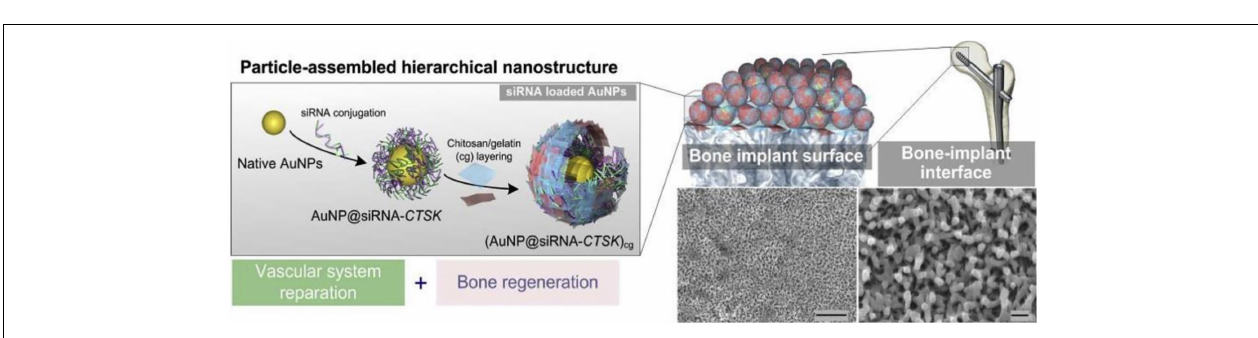
FIGURE 9 | Strategy for fabrication of MANF hydrogels from gelatin nanofibrous microparticles. Reproduced from Hou et al. (2019) with permission from Elsevier (Copyright 2019).